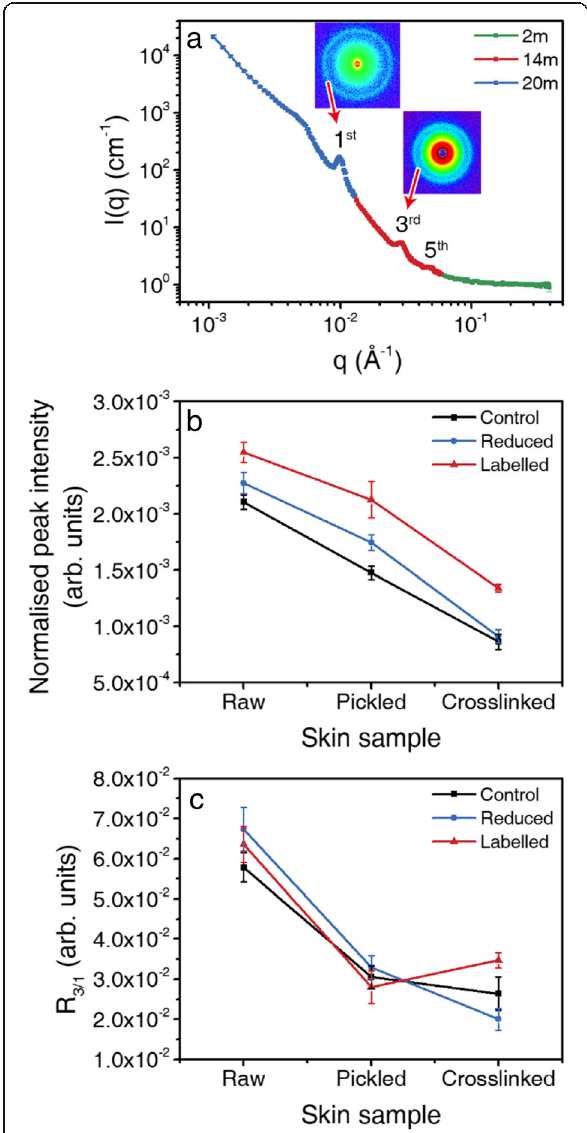
Fig. 4 Results from SANS analysis on skin samples. a 2D SANS scattering pattern of collagen in non-reduced raw skin collected at sample-to-detector distances of 2 m, 14 m and 20 m. The corresponding 1D q-plots obtained by radial averaging of the azimuthal intensity of the 2D patterns are also shown. The diffraction peaks from collagen in skin were labelled by orders (1st, 3rd and 5th). b Average of normalised intensity of the 1st and 3rd order diffraction peaks decreased from raw to crosslinked stage. c Relative intensity of the 3rd to 1st order diffraction peaks (R 3/1 ) decreased from raw to pickled stage while showing different trends from pickled to crosslinked stage between labelled and non-labelled skin samples